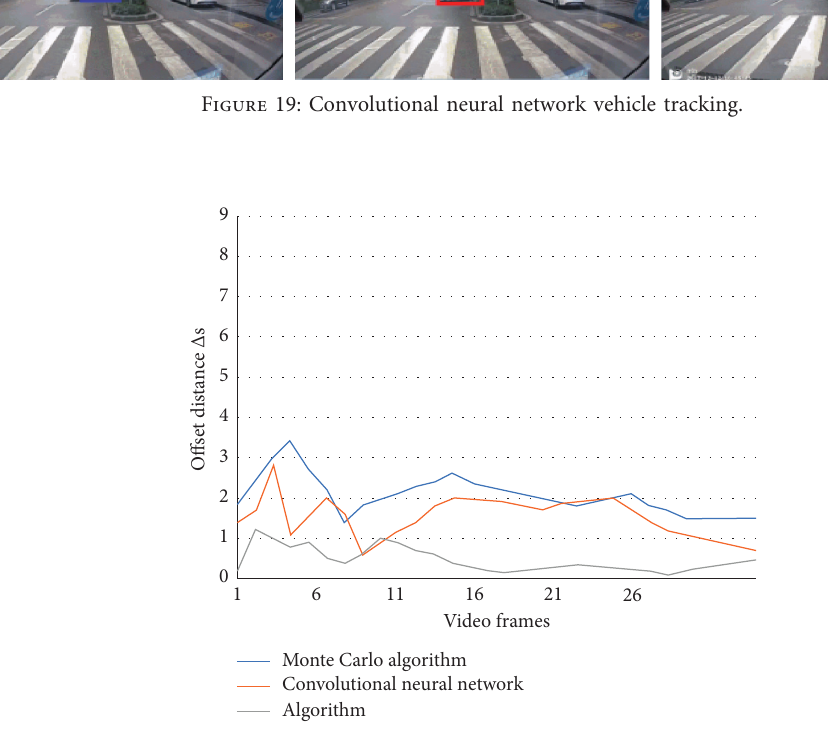
Figure 20: Comparison of vehicle offset distances with different